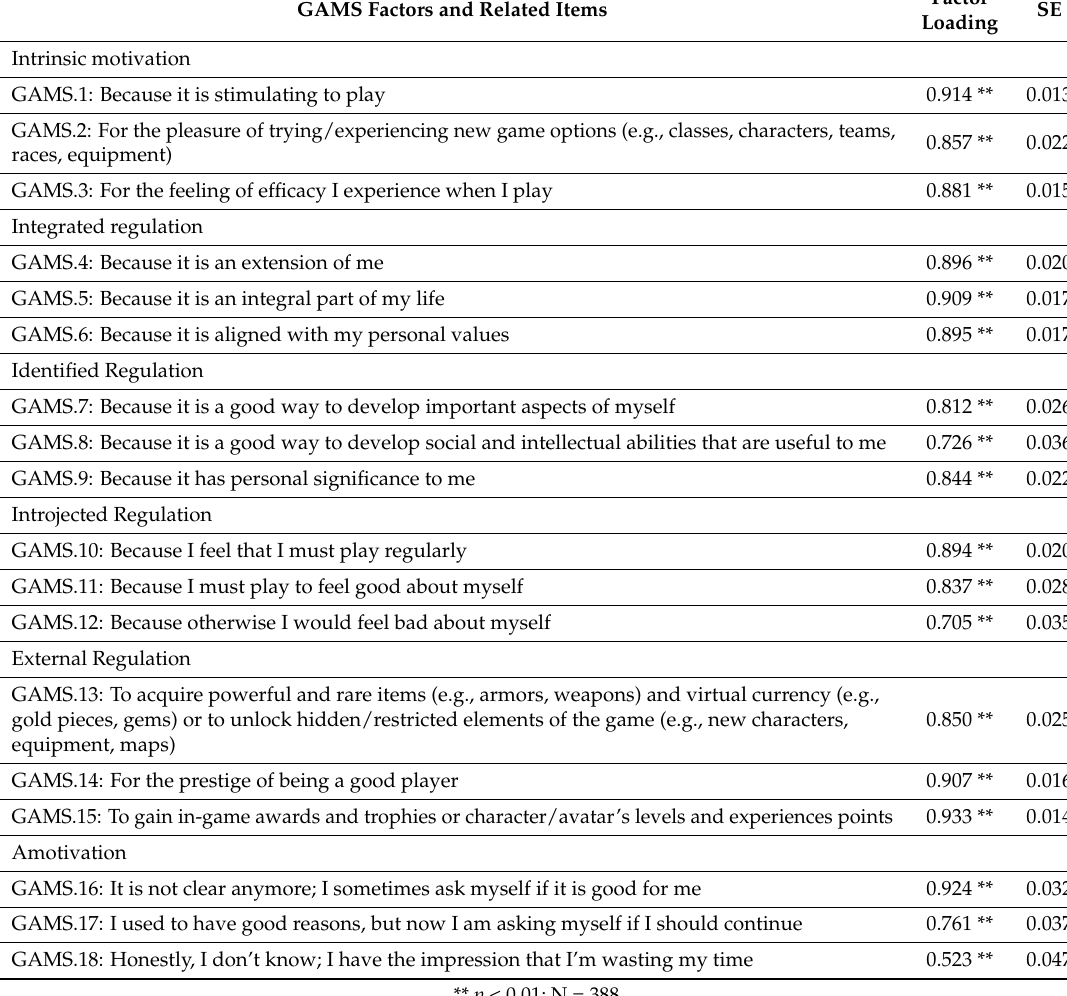
Table 1. Standardized factor loadings with Robust SE for the six factors of GAMS-it (N = 388). GAMS Factors and Related Items